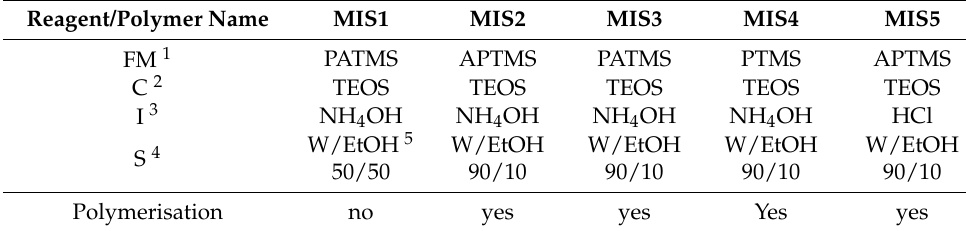
Table 1. Experimental design for the synthesis of the five